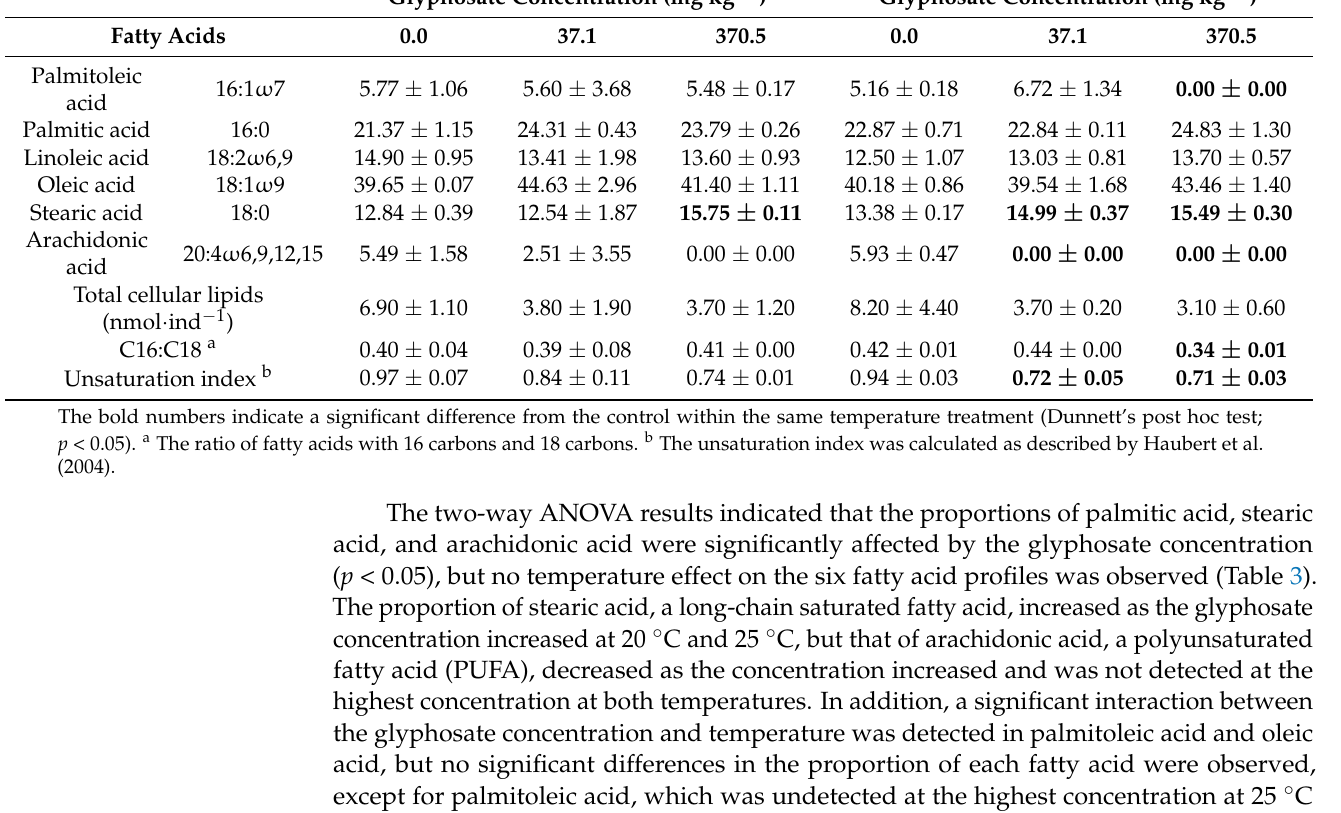
Table 3. Two-way analysis of variance results on the effects of glyphosate and temperature on the individual fatty acid contents in Allonychiurus kimi (Lee) adults after 28 day of exposure to glyphosate. Glyphosate (G) Temperature (T) G × T Fatty Acids F